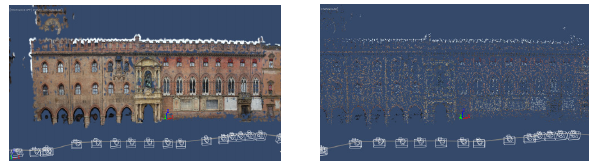
Figure 5. Campidoglio Square, Rome, Manual Reconstruction